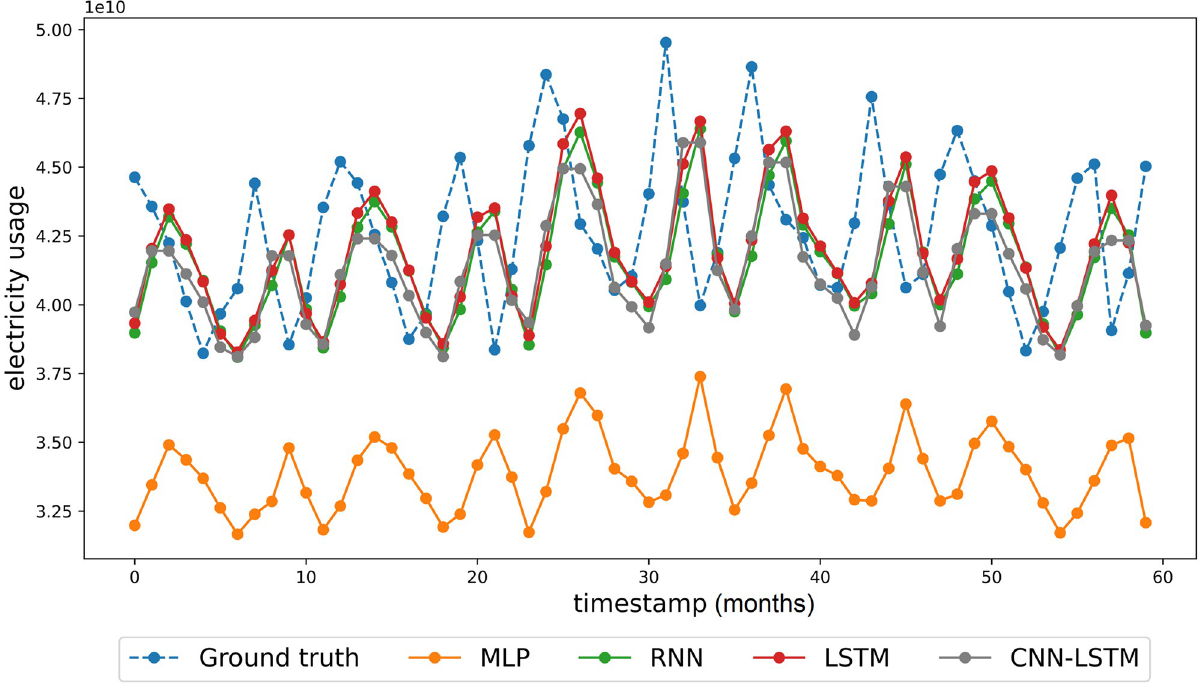
Fig 4. Comparison of national forecasting performance.